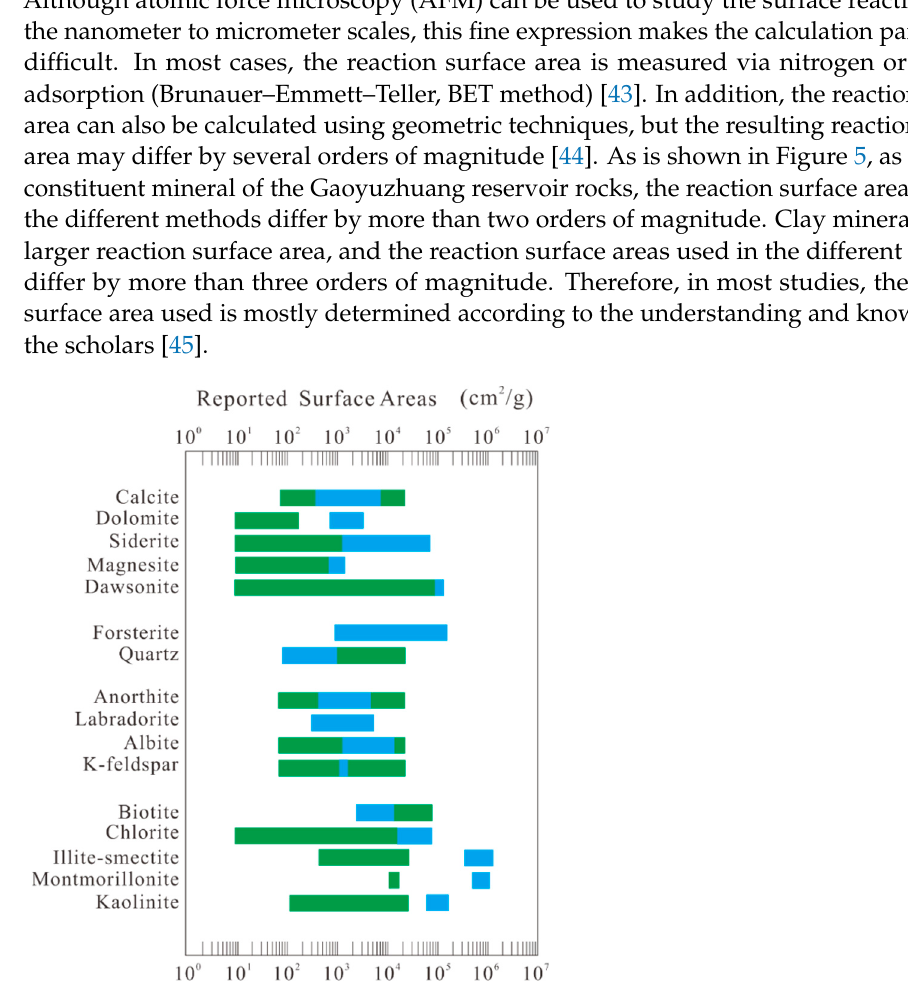
Figure 5. Reaction surface area of the different minerals [44]. Blue represents the reaction surface area measured via the BET method and green represents the reaction surface area used in the different reaction transport simulations.